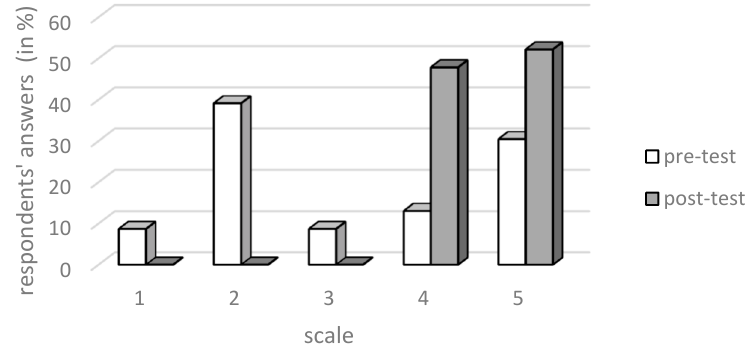
Figure 5. Respondents’ answers to question no. 2 (in %) in pre-test and post-test.